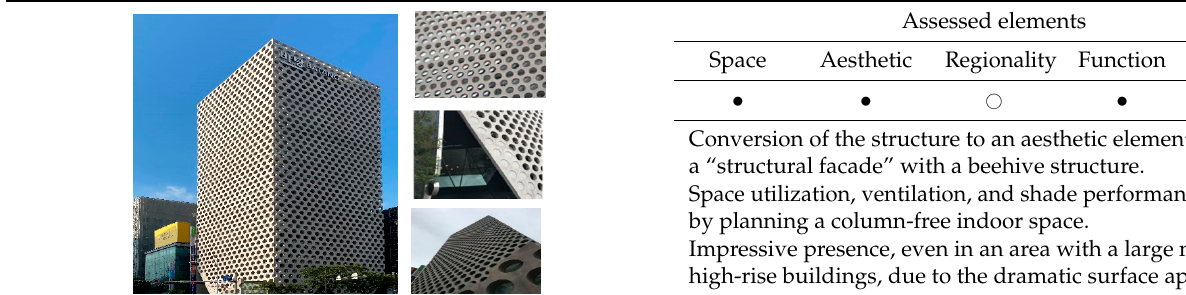
Table 3. Structural facades: Urban Hive (Archium 2008).